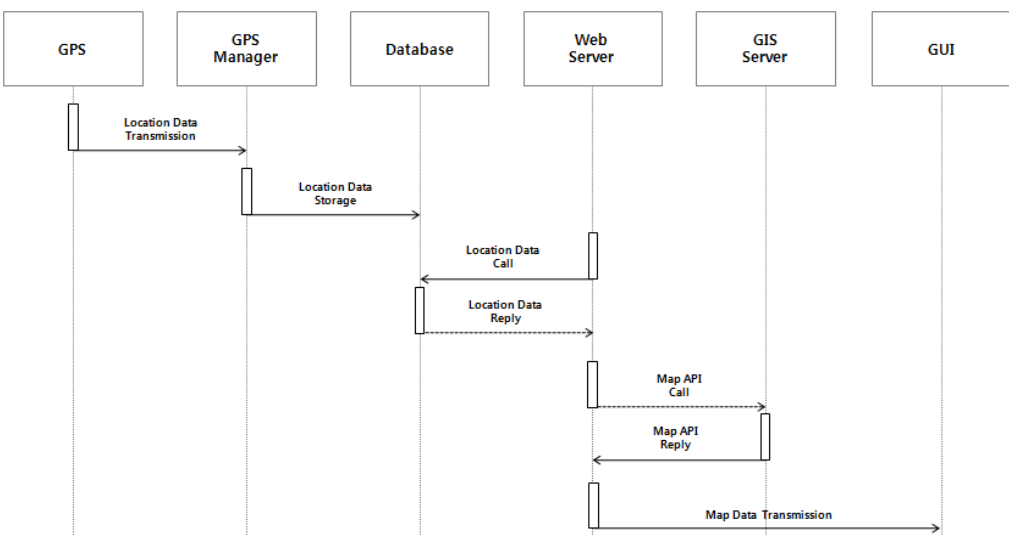
Figure 4. Operation Process of the Location Monitoring